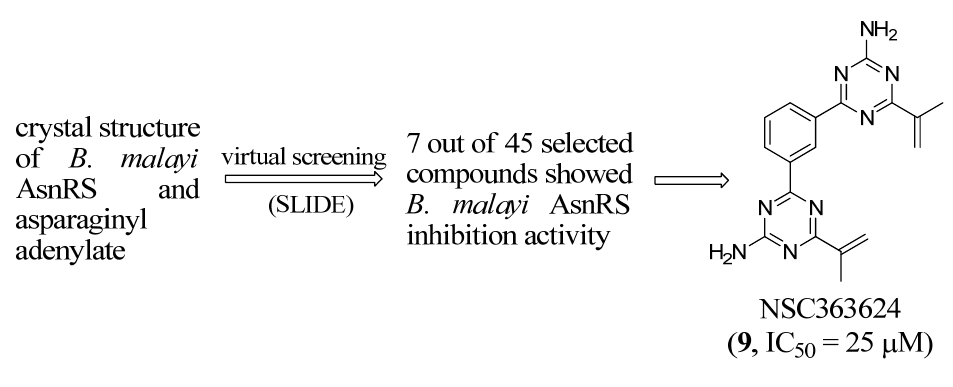
Figure 4. Inhibitor identification scheme of Sukuru et al. (2006) for AsnRS